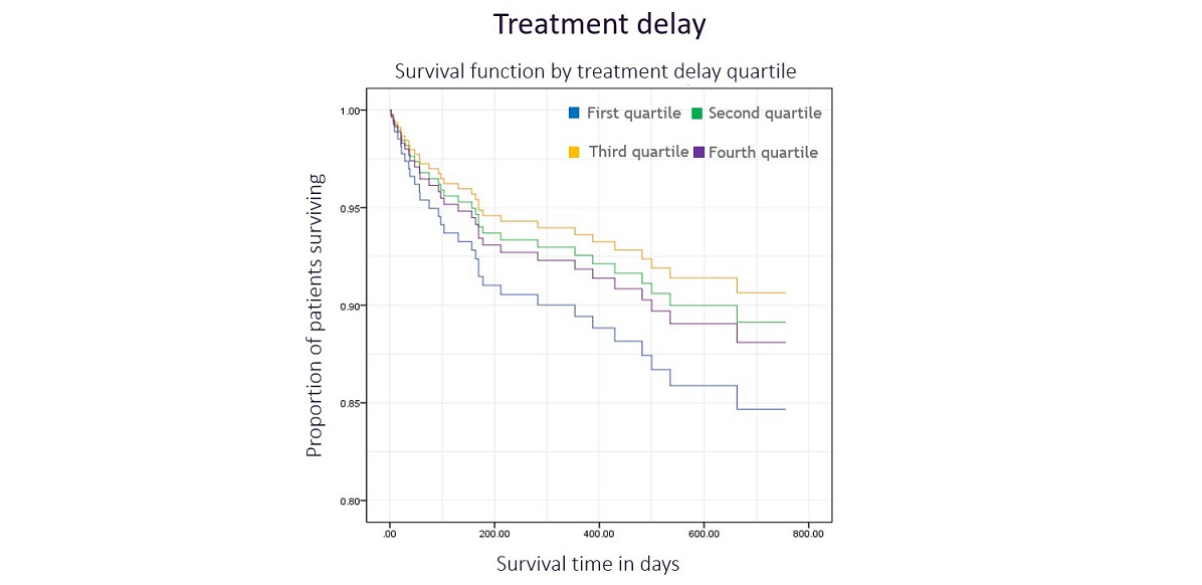
Figure 4. Kaplan-Meier plot illustrating the survival function by treatment delay quartile with